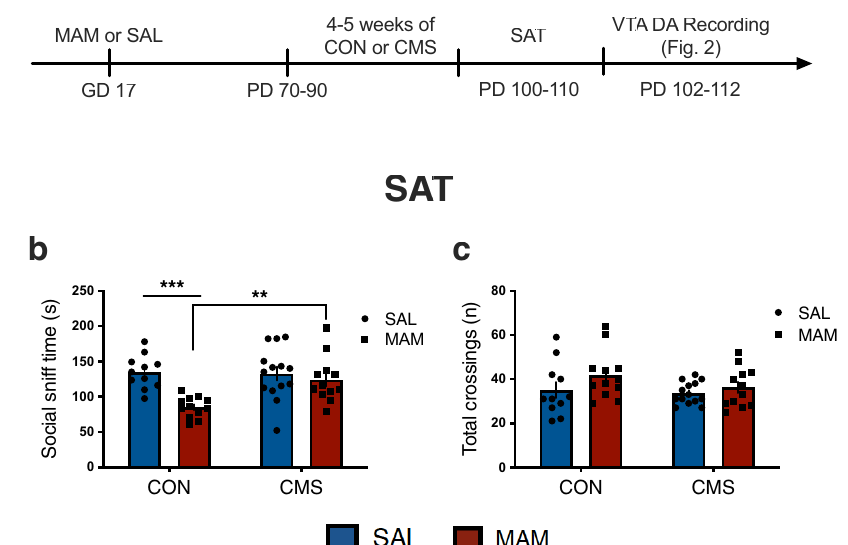
Fig. 1 Rats treated with prenatal MAM exhibit attenuated social motivation. a Timeline of experimental design. b MAM-CON animals exhibited reduced social sniff time compared with vehicle-treated controls (SAL-CON) and MAM-CMS rats (two-way ANOVA interaction followed by Tukey ’ s: p < 0.05, n = 11 – 14 per group). b No effect of MAM treatment ( p = 0.09) or CMS exposure ( p = 0.20) was found for total number of crossings, suggesting no impact on locomotor activity. Error bars represent mean ± SEM. Blue bars and circles represent SAL animals; red bars and squares represent MAM animals. CON groups are plotted on the left and CMS groups are plotted on the right. ** p < 0.01, *** p <